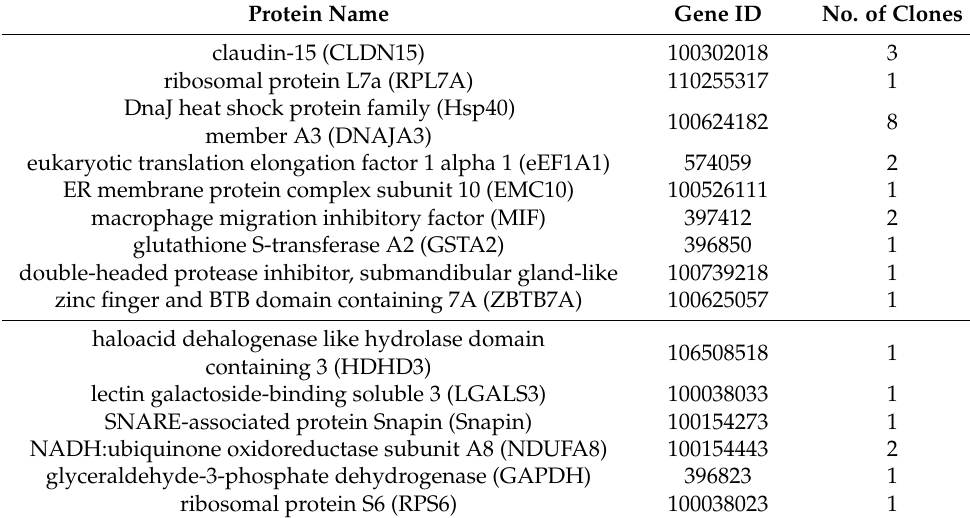
Table 2. Host proteins that interact with PEDV S1 protein as determined by yeast two-hybrid